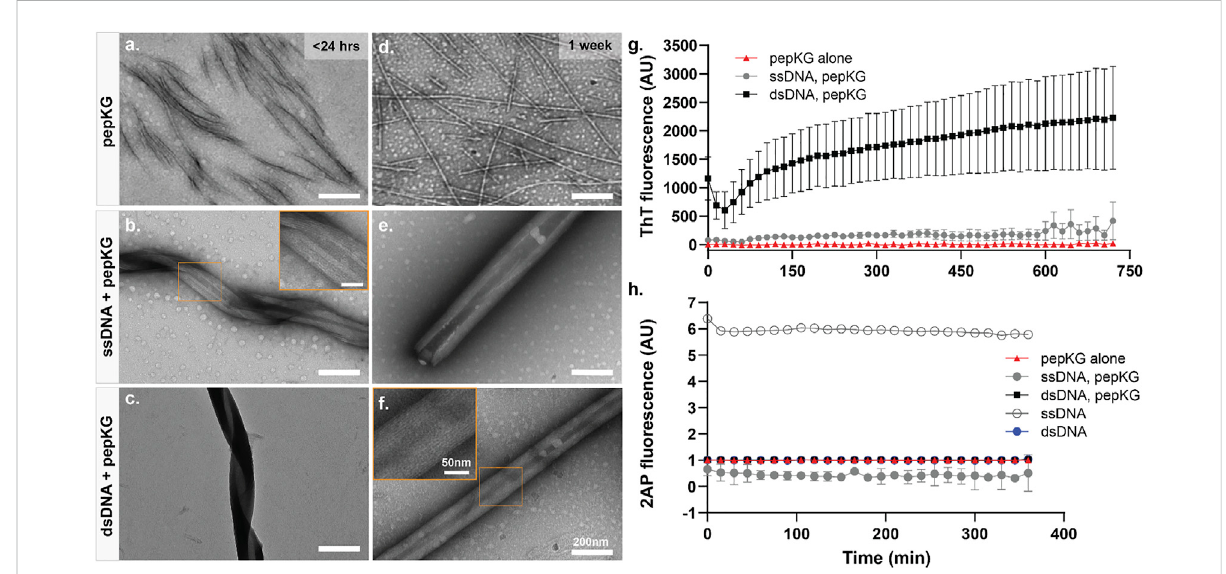
FIGURE 2 Pep-KGassemblyrateisacceleratedwhentemplatedwithdsDNA.TEMimagepanels (A – C) :Pep-KGassembledalone,Pep-KGassembledwith ssDNA, and Pep-KG assembled with dsDNA, respectively, within 1 day of initial dissolution. Panels (D – F) were taken after 1 week of incubation. All peptidesandDNAtemplatesweredissolvedin40%MeCNat1 mMPep-KGconcentrationandcontinuouslyincubatedat37 ° C.MeasurementsofThT fl uorescence (G) indicates cross- β growth of the assembly within the fi rst 12 h and (H) 2AP fl uorescence within the fi rst 6 h of assembly. Each fl uorescence measurement was done at 37 ° C incubation across all timepoints. All error bars are 95% CI values and all samples for 2AP and ThT fl uorescence are n =